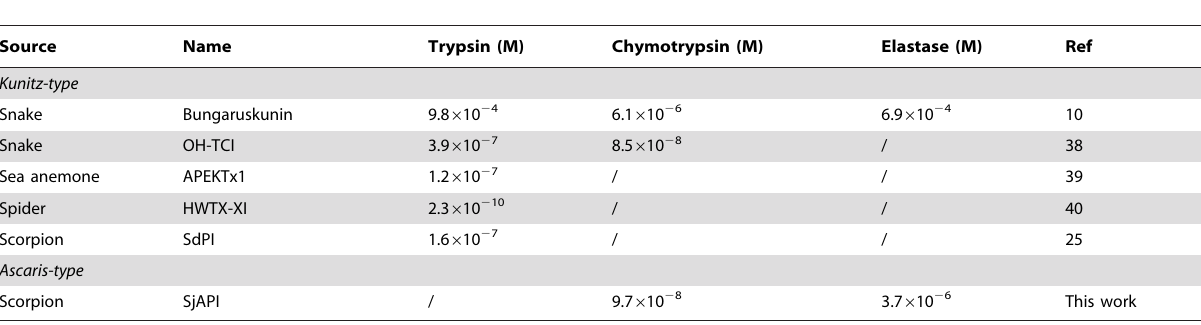
Table 1. Serine protease inhibitors from animal